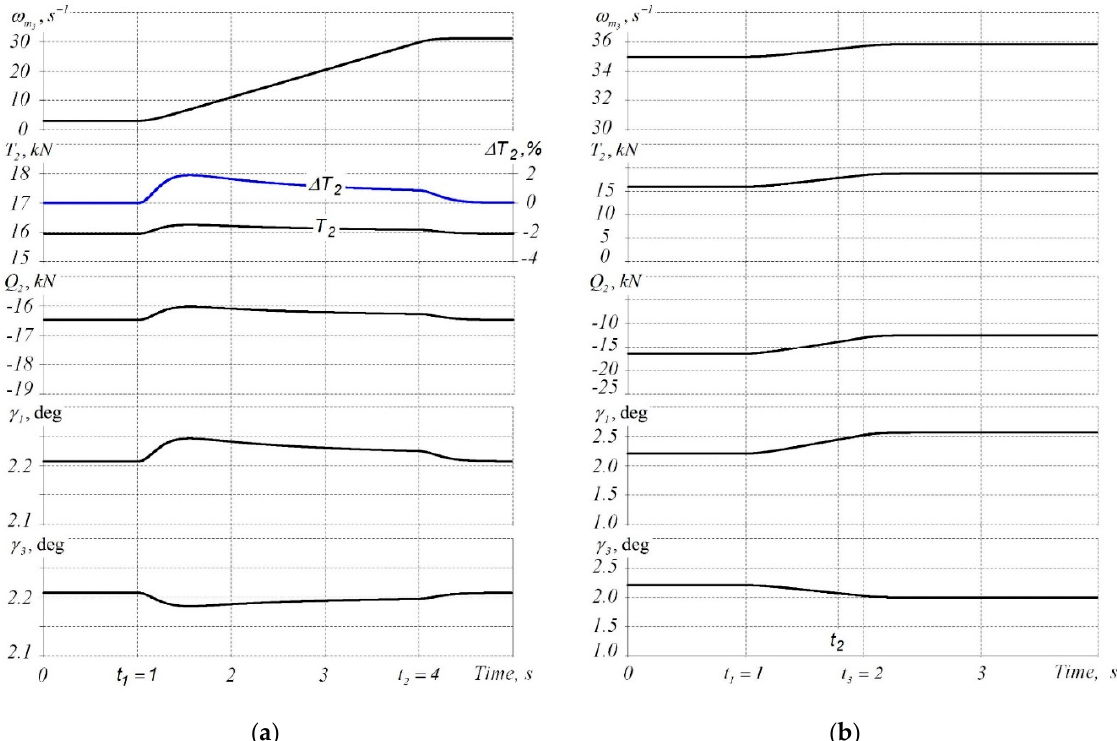
Figure 14. Results of modeling the acceleration processes for the rolling block ( a ) and changes in tension in the second inter-stand space ( b ).